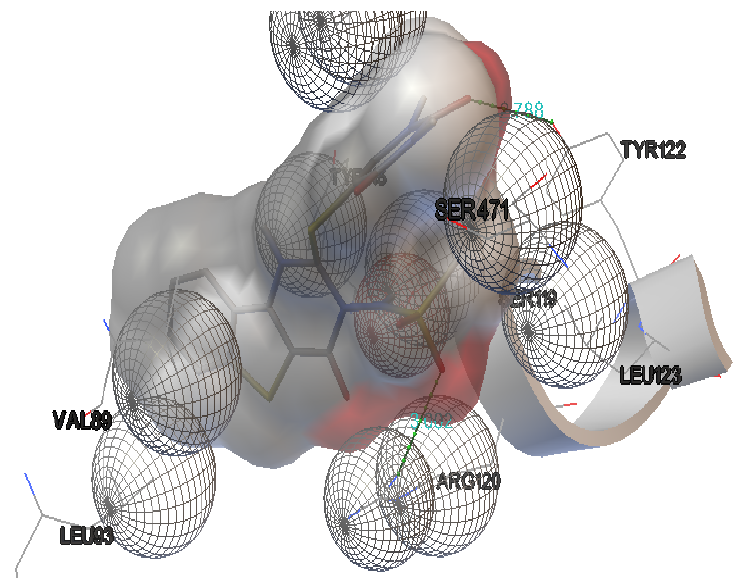
Figure 3. Binding of 2 into the active site of